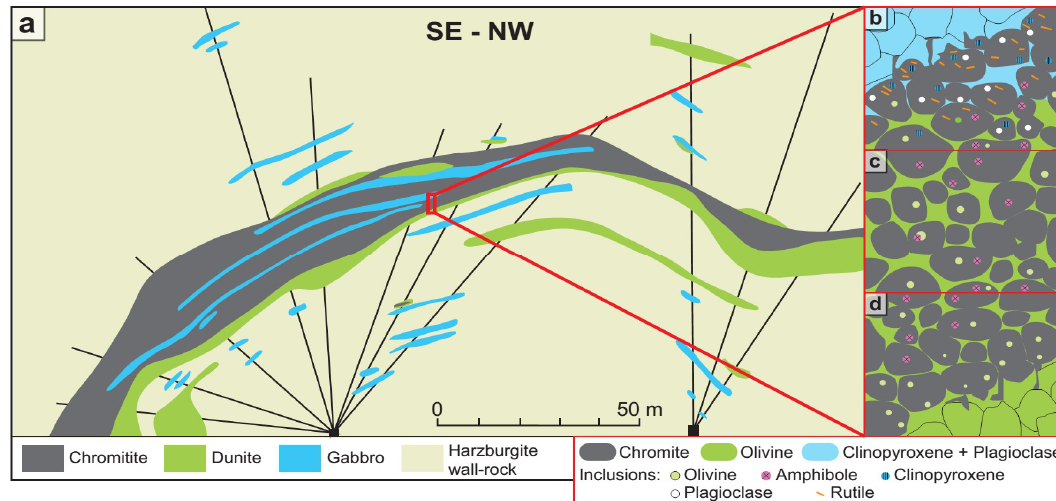
Figure 2. ( a ) Cross‐section through the Mercedita chromitite. The relationships between chromitite, dunite, gabbros and harzburgite were interpreted from holes drilled upward from the roof of the mine’s galleries; ( b ) Mineral inclusions in Mercedita chromite grains near the contact with gabbro; ( c ) Mineral inclusions in Mercedita chromite grains in the inner part of the chromitite body; ( d ) Mineral inclusions in Mercedita chromite grains near the dunite envelope. ( b – d ) are not to